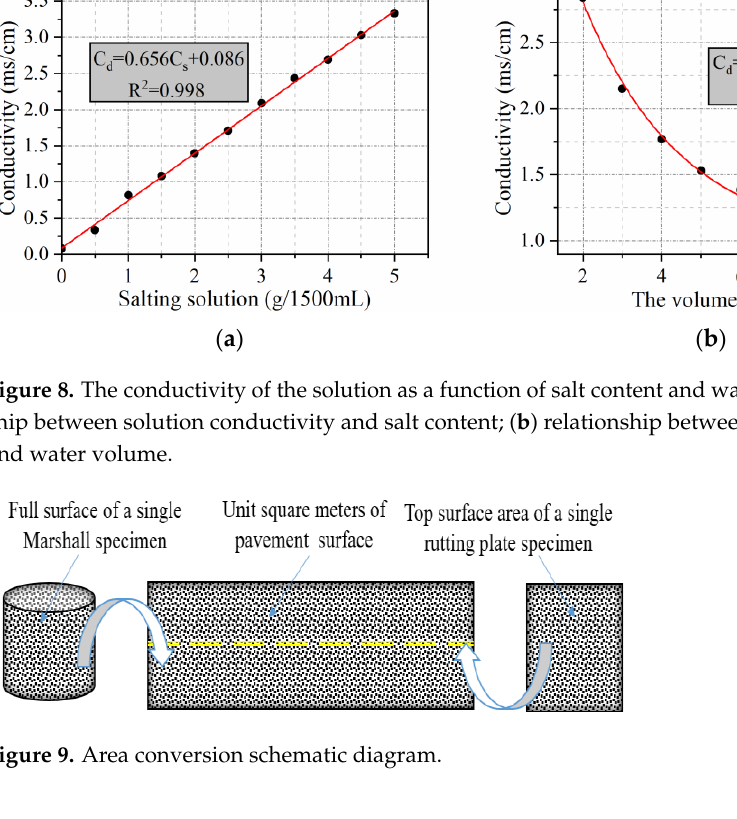
Figure 7. Schematic diagram of research route.